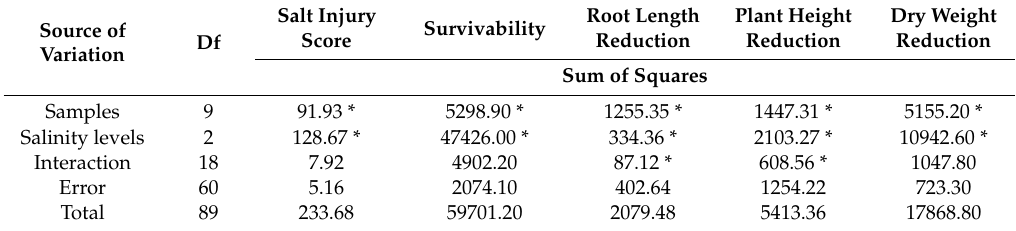
Table 5. Analysis of variance for salt-tolerance parameters of rice.